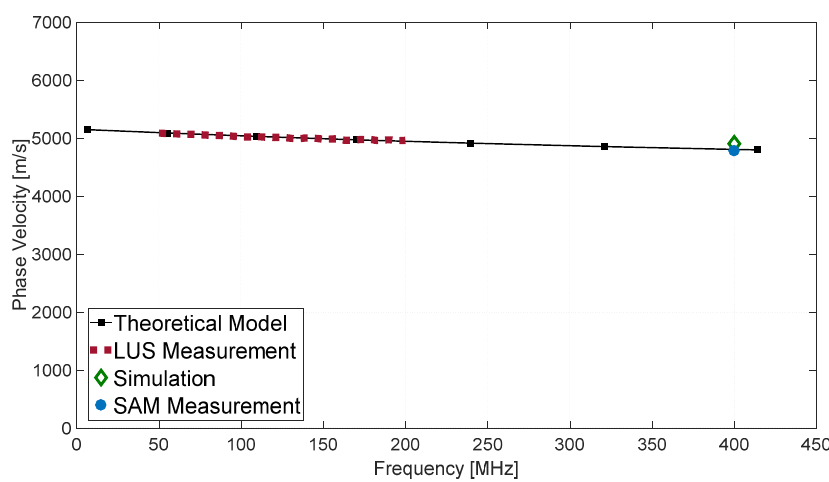
Figure 8. Rayleigh wave velocity as function of frequency for a 1 μ m aluminium coating on silicon.